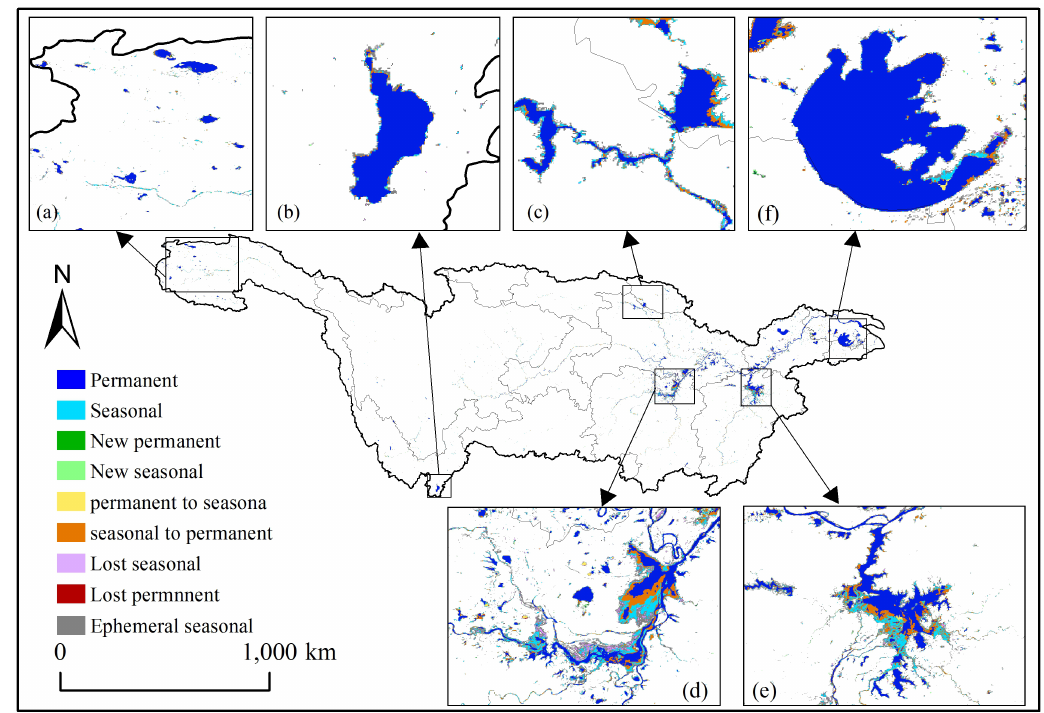
Figure 9. Transitions in surface water class 2001–2015 in YRB. Types of water change: unchanged permanent (UP), unchanged seasonal (US), new permanent (NP), new seasonal (NS), seasonal to permanent (S2P), permanent to seasonal (P2S), lost seasonal (LS), lost permanent (LP) and Ephemeral seasonal (ES). ES water is defined that water inundation frequency less than 5% for both 2001–2005 and 2011–2015. ( a ) Source region of the Yangtze River; ( b ) Dianchi Lake; ( c ) Danjiangkou Reservoir; ( d ) Dongting Lake; ( e ) Poyang Lake; ( f ) Tai Lake. The area of changed seasonal and permanent (including NP, LP, NS, LS, S2P and P2S) water is